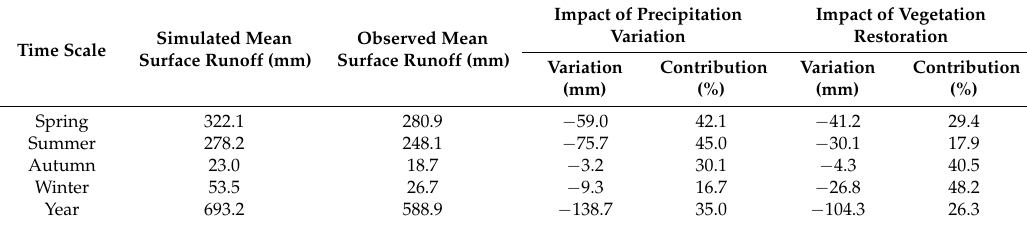
Table 3. Calculating results of contribution rates of precipitation variation and vegetation restoration to surface runoff